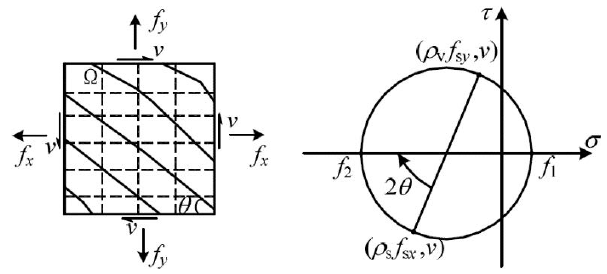
Fig. 2 The stress balance condition and stress Mohr circle of the tiny body